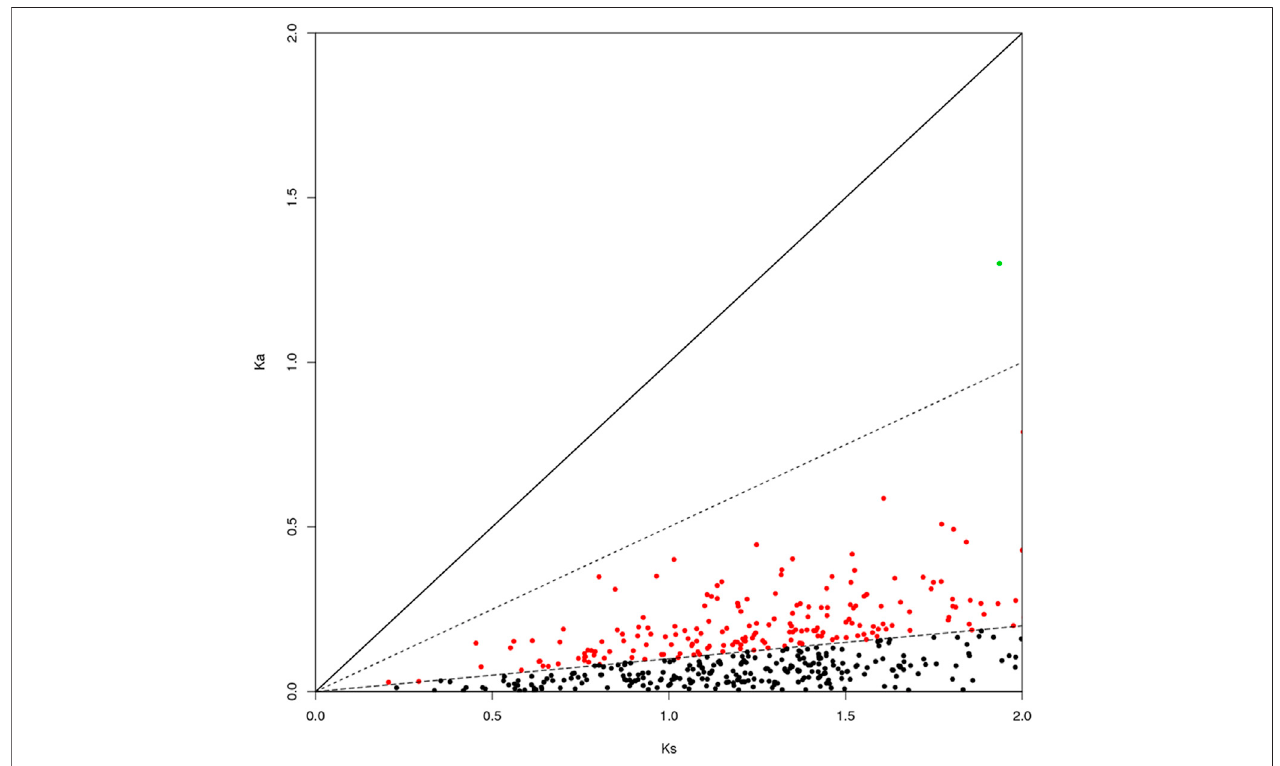
FIGURE 9 | Scatter plot of Ka/Ks obtained by comparing Zeugodacus cucurbitae (Coquillett) and Ceratitis capitata (Wiedemann). Note: the region of blue spot: strong positive select genes; the region of green spot: weak positive selection genes; the region of black spot: puri fi cation selection genes.